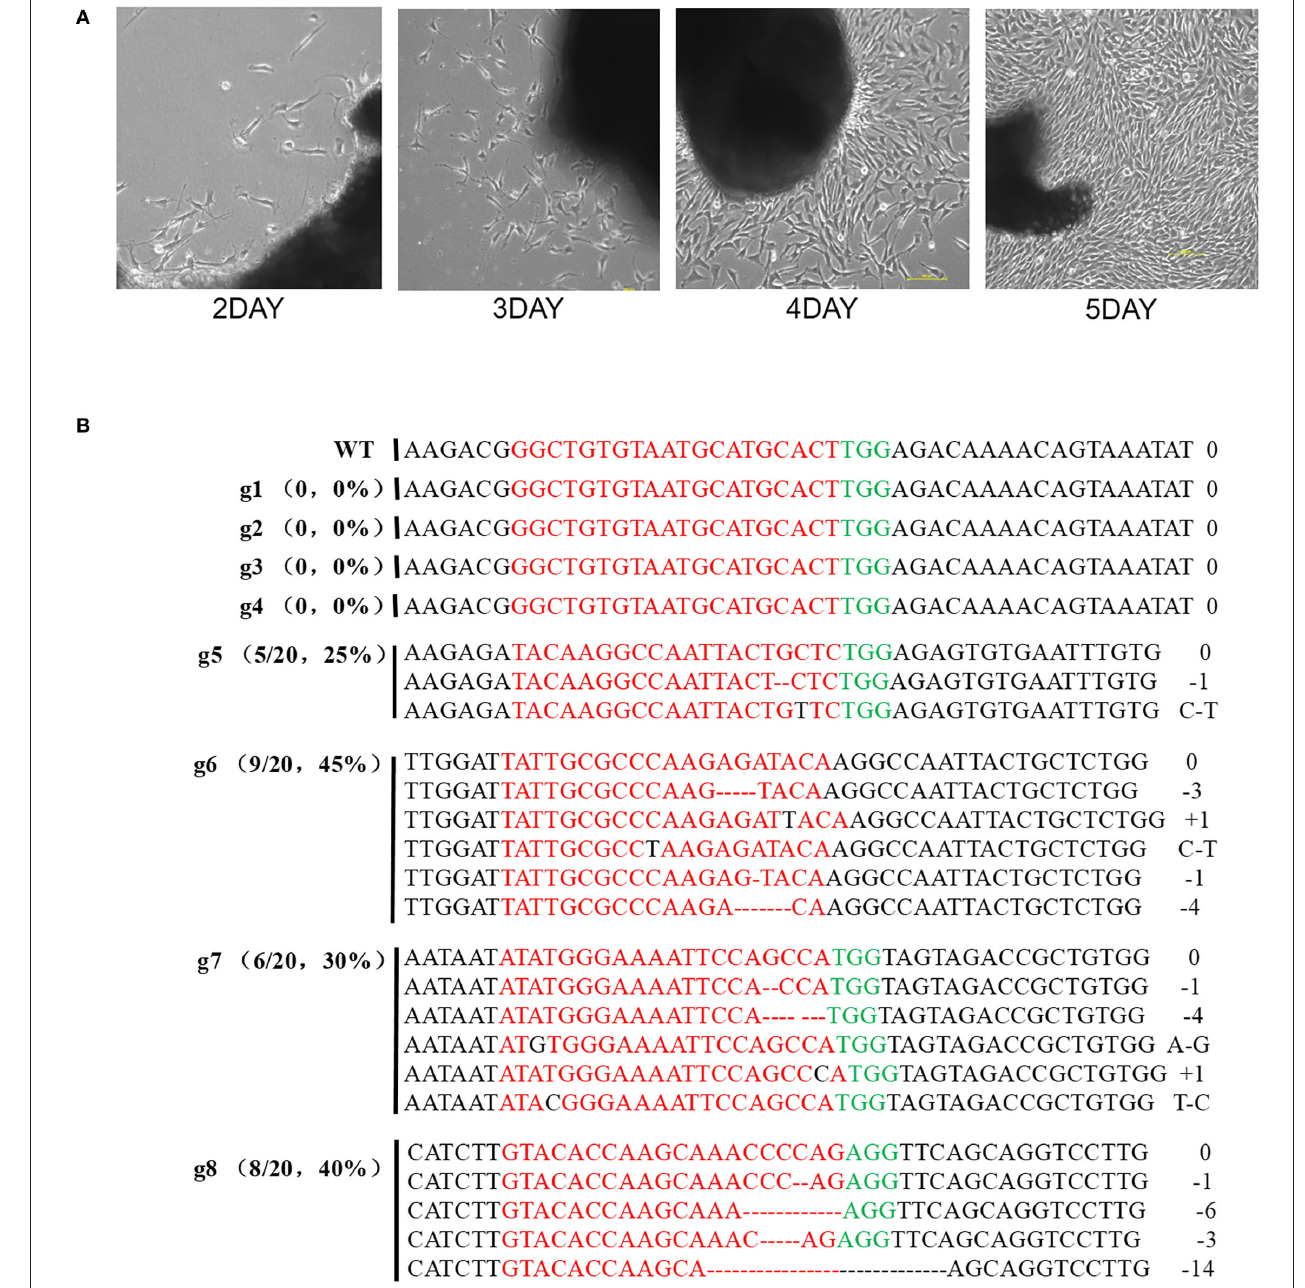
FIGURE 2 | The results of sequencing for mutations at the specific sites in rabbit REFs. (A) Rabbit Primary fibroblast cell in culture from 2days to 5days. (B) Sanger sequence analysis of REFs. g1-g4 target to exon1, g5-g8 target to exon 3. gRNA edited were named on the left. g1-g8 represent different gRNA, PAM sequence is marked in green. The sgRNAs sequence is marked in red. The numbers on the right indicated the type of mutation, with “-” represents deletion of the given number of nucleotides, “ + ” represents insertion of the given number of nucleotides.